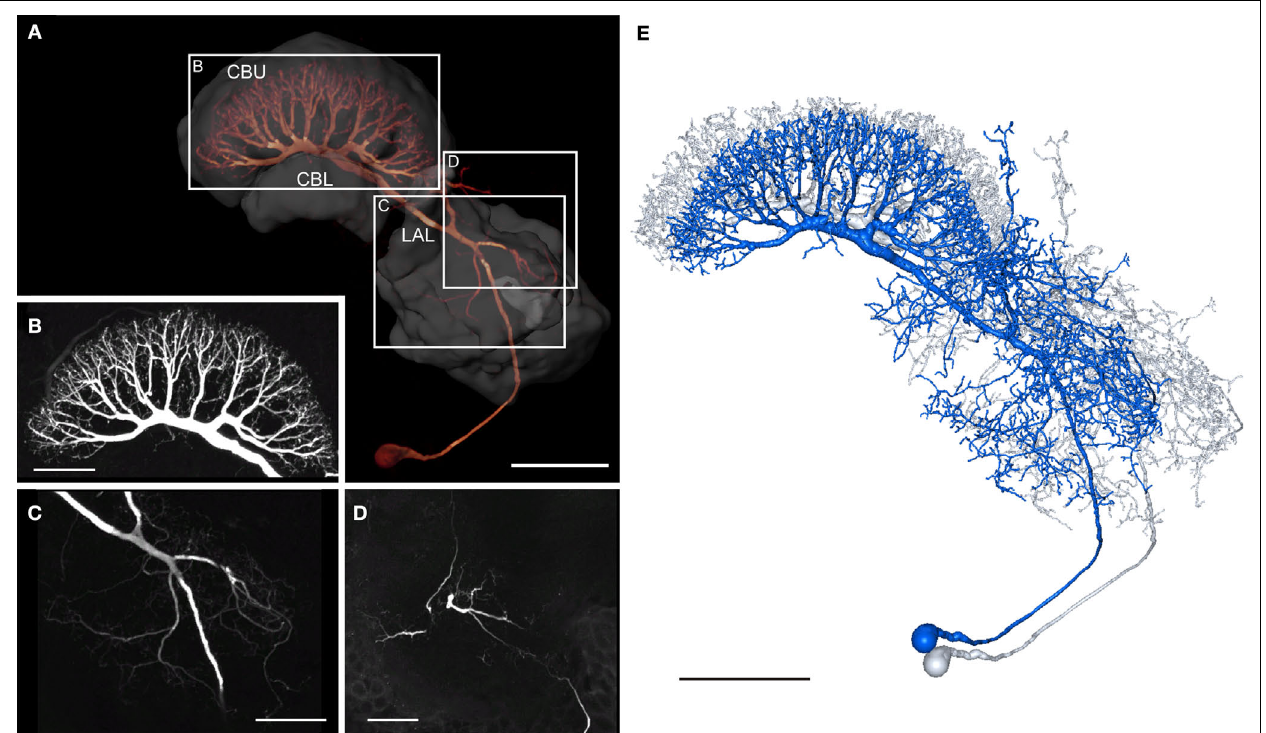
FIGURE 6 | Morphology of the giant fan-shaped (GFS) neuron. (A) Anterior view of the GFS neuron by direct volume rendering. Reconstructions of central-complex neuropils and the lateral accessory lobe are shown transparently. CBL, lower division of the central body; CBU, upper division of the central body; LAL, lateral accessory lobe. Boxes show areas enlarged in B–D . (B) Maximum intensity projection of the arborization tree in